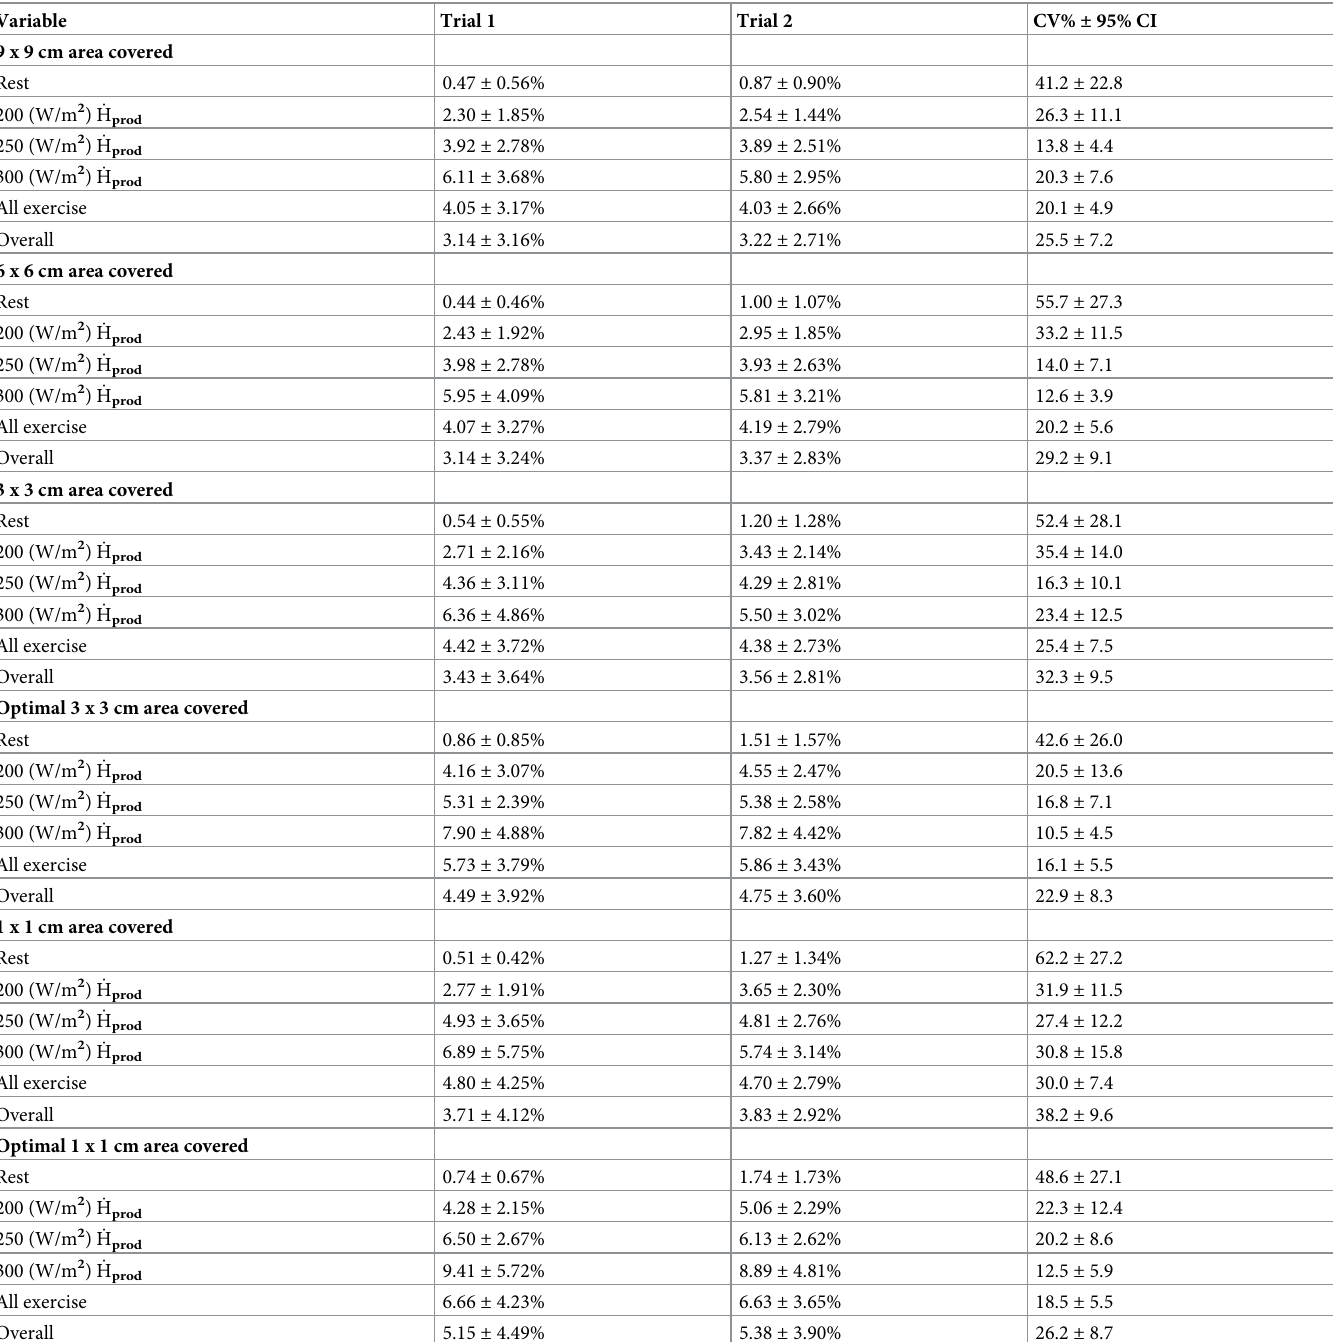
Table 3. Mean, standard deviation and reliability of sweat gland activation (area covered) at rest and a range of exercise intensities.